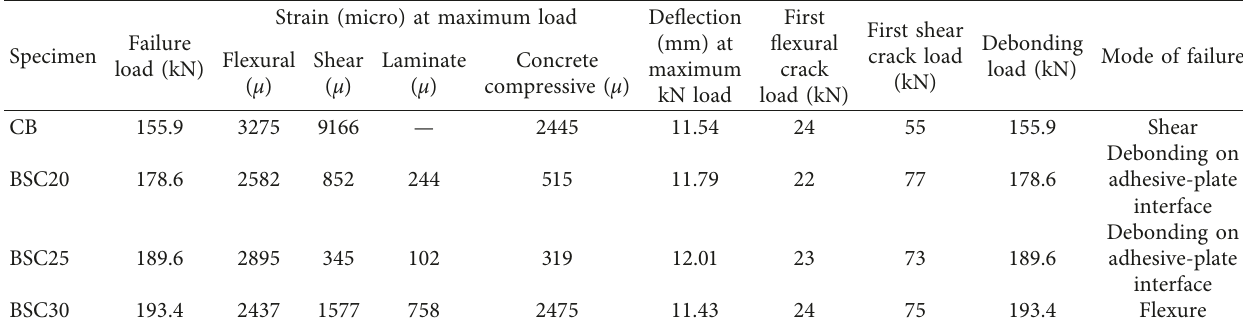
Figure 4: Experimental failure mode of beams (a) CB, (b) BSC20, (c) BSC25, and (d) Table 2: Experimental results.